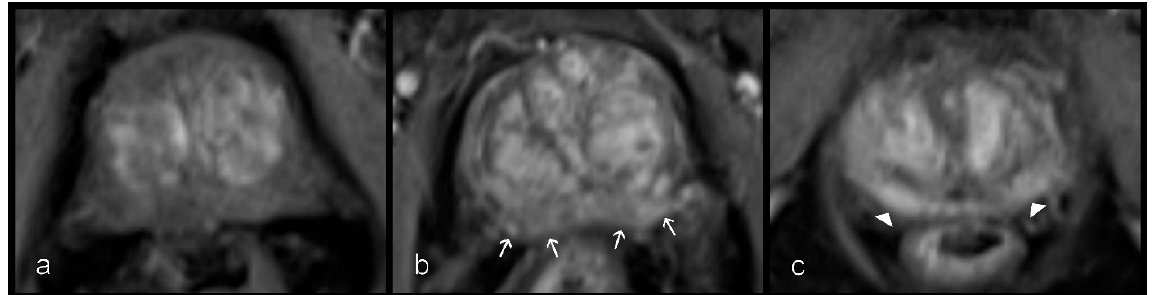
Figure 4. Different levels of enhancement on contrast-enhanced csVIBE sequences in the peripheral zone. ( a ) No, ( b ) mild (white arrows), and ( c ) severe and early enhancement (arrowheads). No and mild enhancement were combined. csVIBE, native T1 and prototypical dynamic T1 gradient echo sequence.